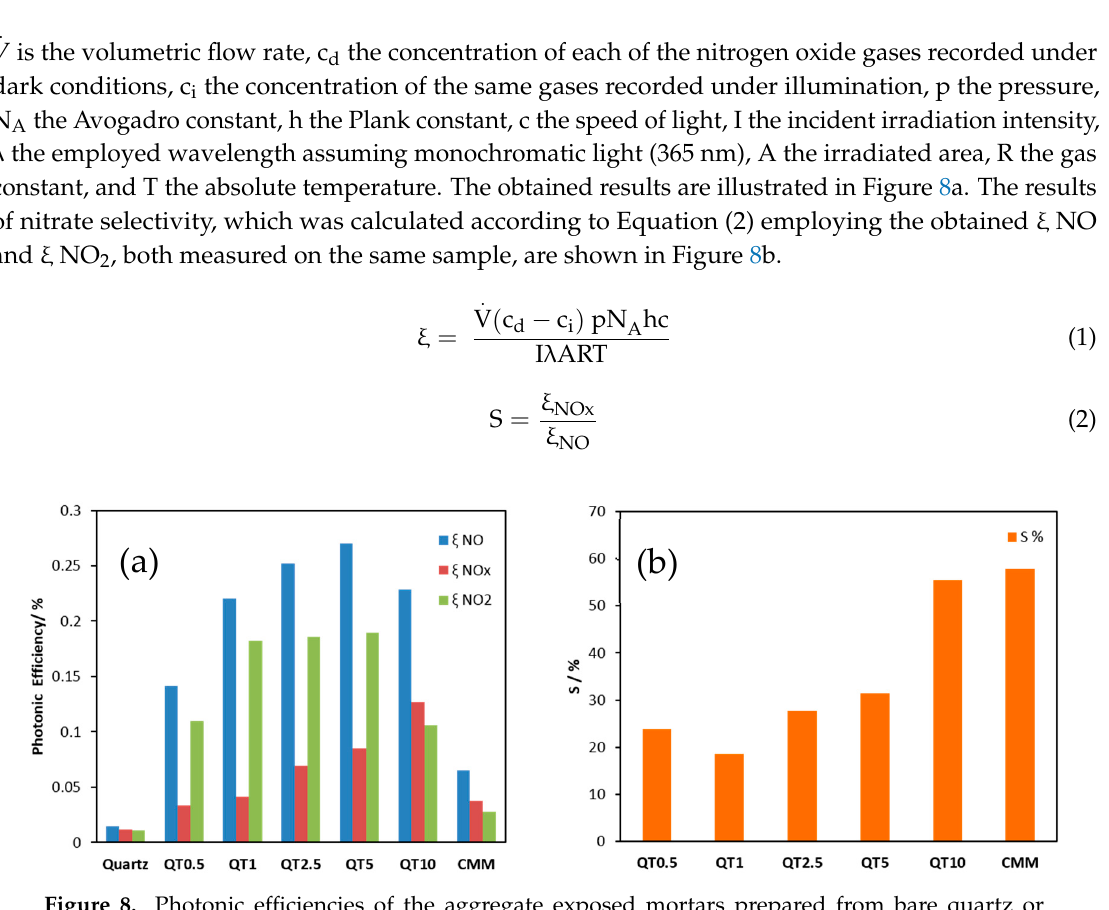
Figure 8. Photonic efficiencies of the aggregate exposed mortars prepared from bare quartz or TiO 2 -modified quartz for NO and NOx removal and for NO 2 formation ( a ), and nitrate selectivity recorded for the same samples ( b ).